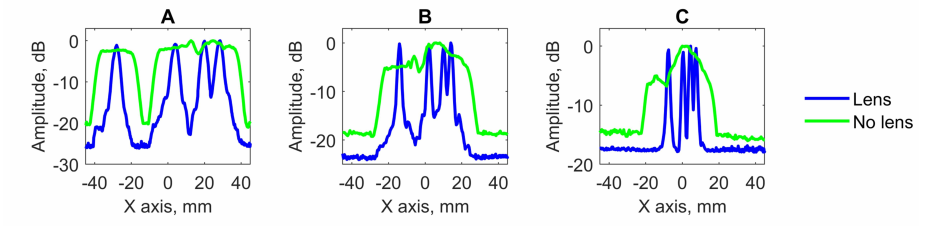
Figure 12. Lateral profiles of results obtained for block ( A ) D, ( B ) E, and ( C ) F on the X axis. According to the obtained results for the blocks D, E, and F, the defect characterization task can be solved effectively by the application of PR-FZP. According to the obtained results, it is possible to conclude that all closely spaced defects in testing specimens have been resolved. This conclusion can be reached using the obtained lateral profiles of results (Figure 12) at which peaks related to the flaws decrease by at least − 6 dB with respect to the peak maximum with lower amplitude [29]. Furthermore, the application of PR-FZP made it possible to obtain C-scans of testing blocks with high resolution and SNR which allowed to estimate the sizes of the flaws with high precision. The results of flaws size and SNR estimation for blocks with closely-spaced defects correspond well with the similar results obtained for the blocks with a single